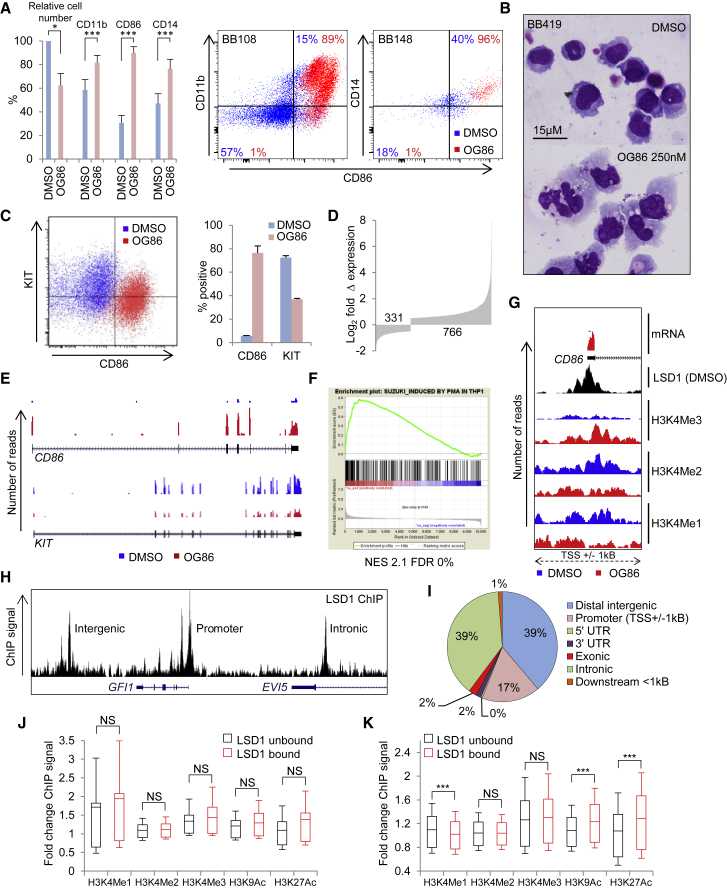
Absence of H3K4Me1 or H3K4Me2 Accumulation at Active Enhancers and Upregulated Promoters following LSD1 InhibitionIn (A) and (B), primary patient AML cells with MLL translocations (n = 8 separate cases) were treated for 7 days in stromal co-culture with 250 nM OG86 or DMSO vehicle.(A) Bar graph and exemplar fluorescence-activated cell sorting (FACS) plots show changes in relative cell numbers and immunophenotype; ∗p < 0.05, ∗∗∗p < 0.005, t test.(B) Exemplar cytospin preparations.In (C)–(K), THP1 AML cells were treated for 24 hr with 250 nM OG86 or DMSO vehicle.(C) Exemplar flow cytometry plot (left) and bar graph (right) indicate expression of CD86 and KIT. Error bars indicate SEM (n = 4).(D) Numbers of up- and downregulated genes.(E) Exemplar RNA-seq tracks.(F) Gene set enrichment analysis plot. NES, normalized enrichment score; FDR, false discovery rate.(G) Exemplar RNA-seq and ChIP-seq tracks.(H) Exemplar LSD1 ChIPseq track.(I) Pie chart indicates genome location annotations for 18,937 LSD1 binding peaks.(J and K) Box-and-whisker plots show mean, 20th, and 80th percentile values (box) and 10th and 90th percentile values (whiskers) for fold change in ChIP signal for the indicated histone marks at (J) promoter regions (TSS ± 2.5 kb) of upregulated genes or (K) active intergenic enhancers (enhancer center ± 2.5 kb), according to LSD1 binding status. ∗∗∗p < 0.001, t test; NS, not significant.See also Figure S1 and Tables S1, S2, and S3.